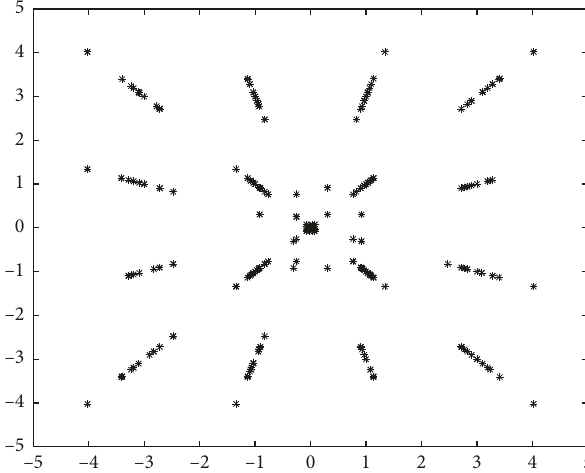
Figure 5: Coordinate reception signal constellation using linear demodulation